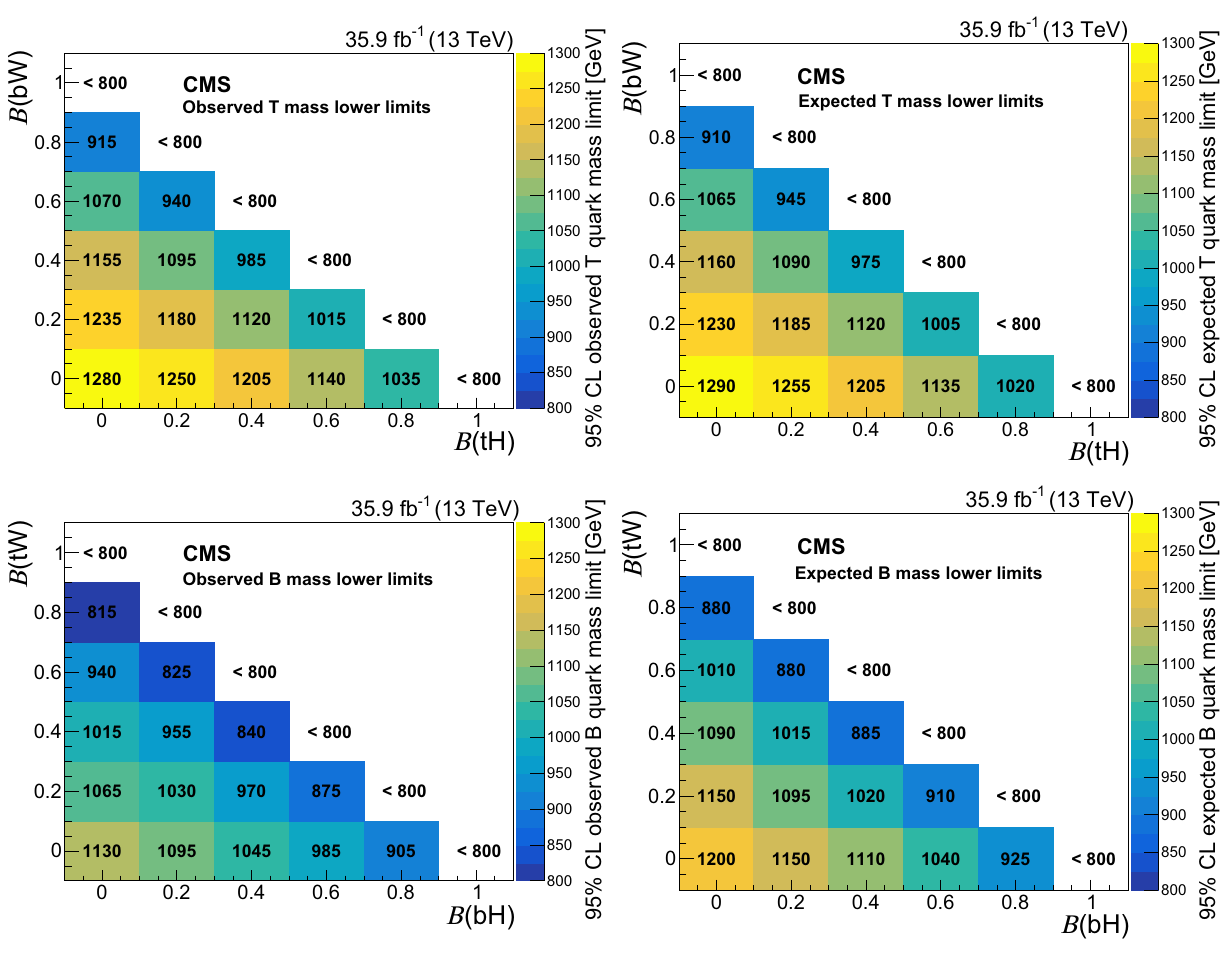
Fig. 5 The observed (left) and expected (right) 95% CL lower limits on the mass of the T (upper) and B (lower) quark, in GeV, for various branching fraction scenarios, assuming B ( T → tZ ) + B ( T → tH ) + B ( T → bW ) = 1 and B ( B → bZ ) + B ( B → bH ) + B ( B → tW ) = 1, respectively B ( B → bH ) + B ( B → tW ) = 1 . 0. For a B quark